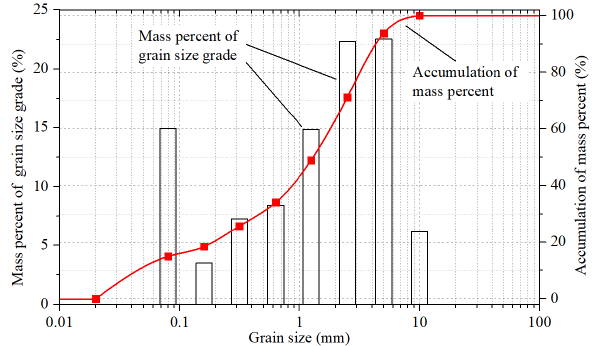
Figure 10. Grain size distribution of sand.